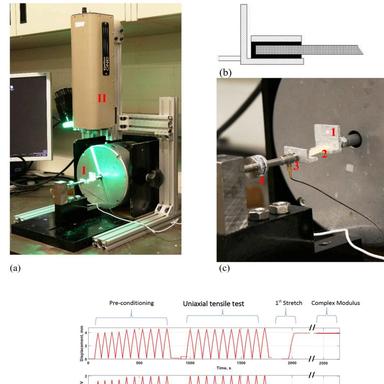
Experimental setup for the complex modulus measurement. (a) I, testing apparatus; II, video extensometer. (b) Scheme of the fixation of the aortic layer to the specimen holder by glue (black in the drawing). (c) Detail of the testing apparatus: 1, laser sport produced from the laser doppler vibrometer used for displacement measurement; 2, aortic strip; 3, piezoelectric dynamic load sensor; 4, static load sensor. (d) Measurement process: pre-conditioning, uniaxial tensile test, stretch, complex modulus test